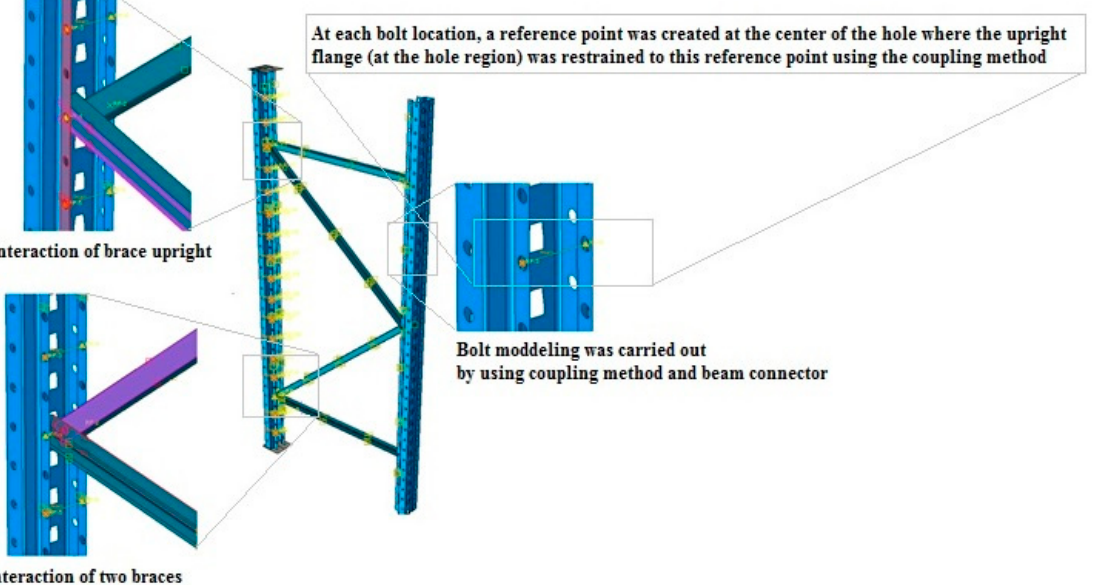
Figure 6. A typical model with a mesh matrix view on the polygon and circular perforations. 2.4. FE Model Verification Data were derived from test results of uprights with 1800 mm, 2400 mm, 3000 mm and 3600 mm heights for both 1.6 mm and 2.5 mm thicknesses. Because of confidentiality